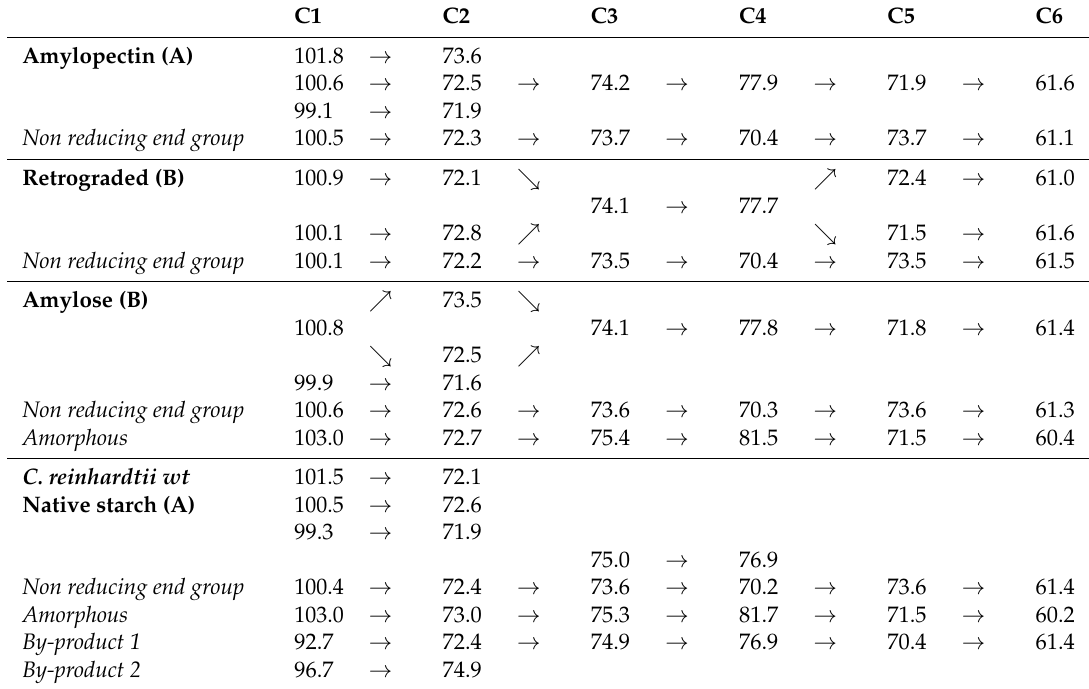
Table 1. 13 C assignments (in ppm) of amylopectin-rich, native retrograded, amylose-rich and native C. reinhardii starches 1